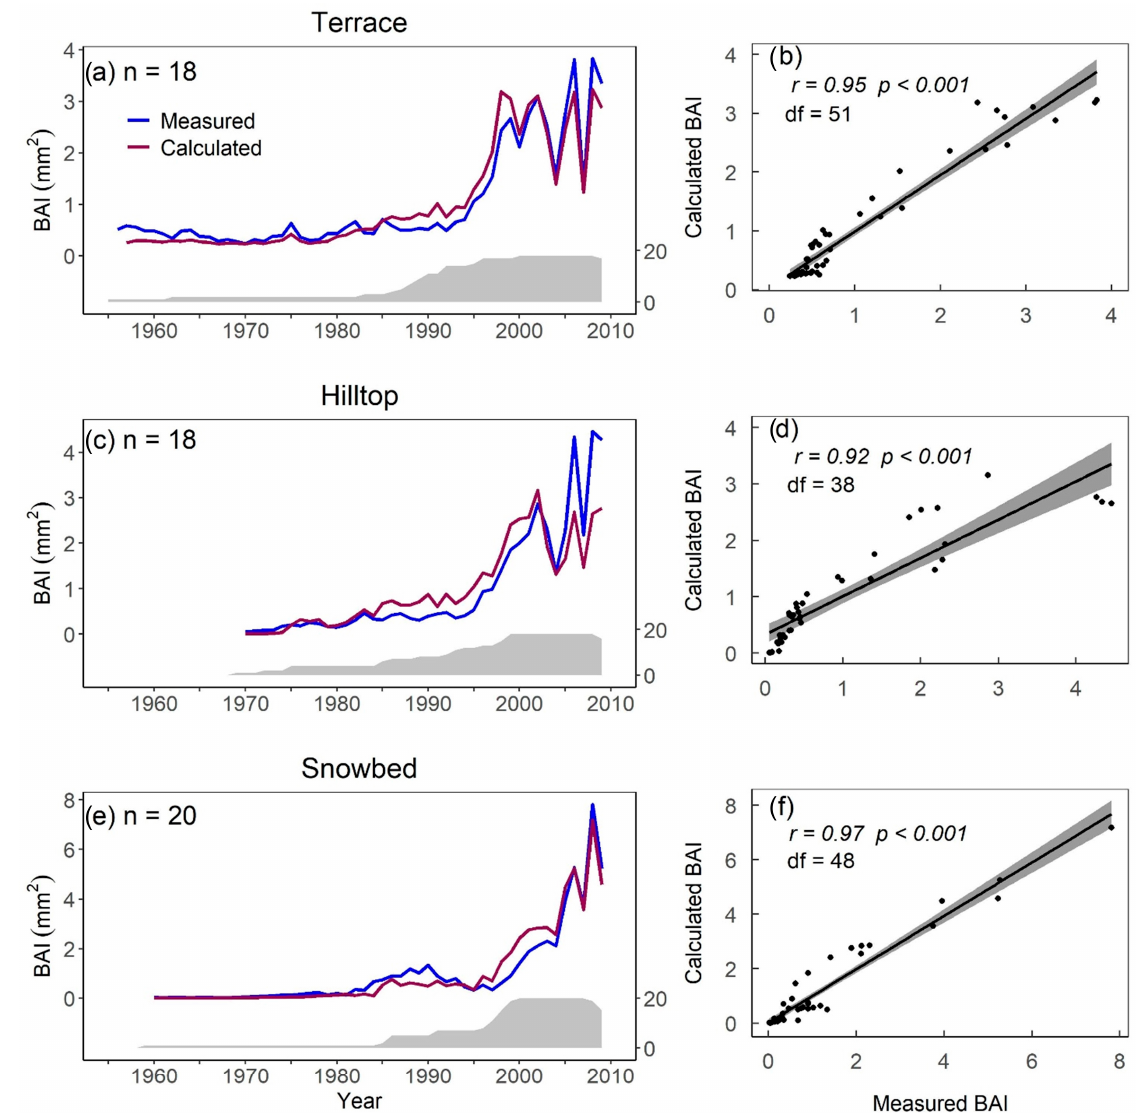
Figure 3. Growth chronologies based on calculated (red) and measured (blue) basal area incre- ment(BAI) data ( a , c , e ) and graphs showing the correlation between the two data types ( b , d , f ). The number of cross-sections used (n), correlation coefficients (r), and degree of freedom of the correla- tions ( d , f ) are given for the three sites. The shaded areas on the left panels represent the sample depth of the series ( a , c , e ).